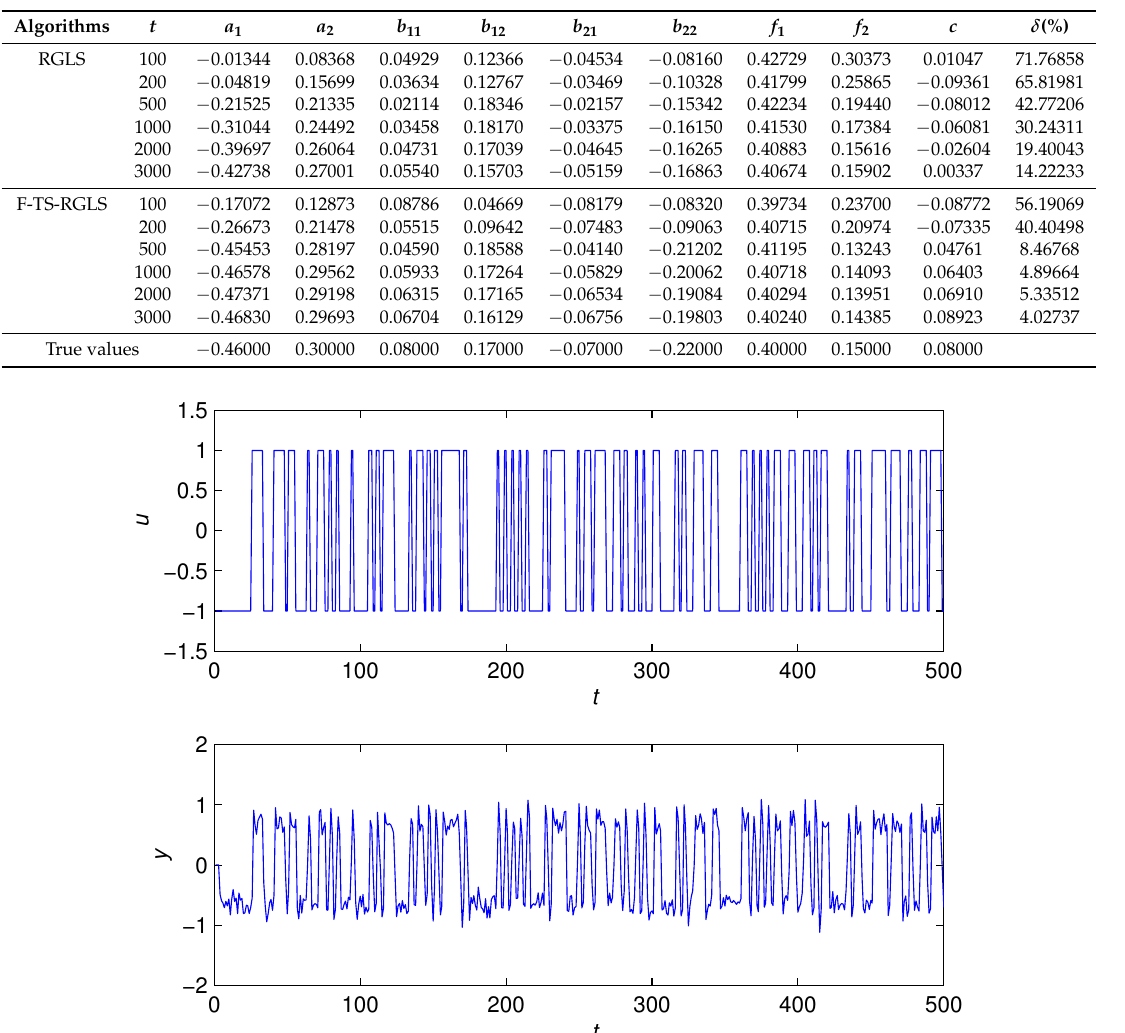
Table 3. The parameter estimates and their errors with σ 2 = 0.10 2 .